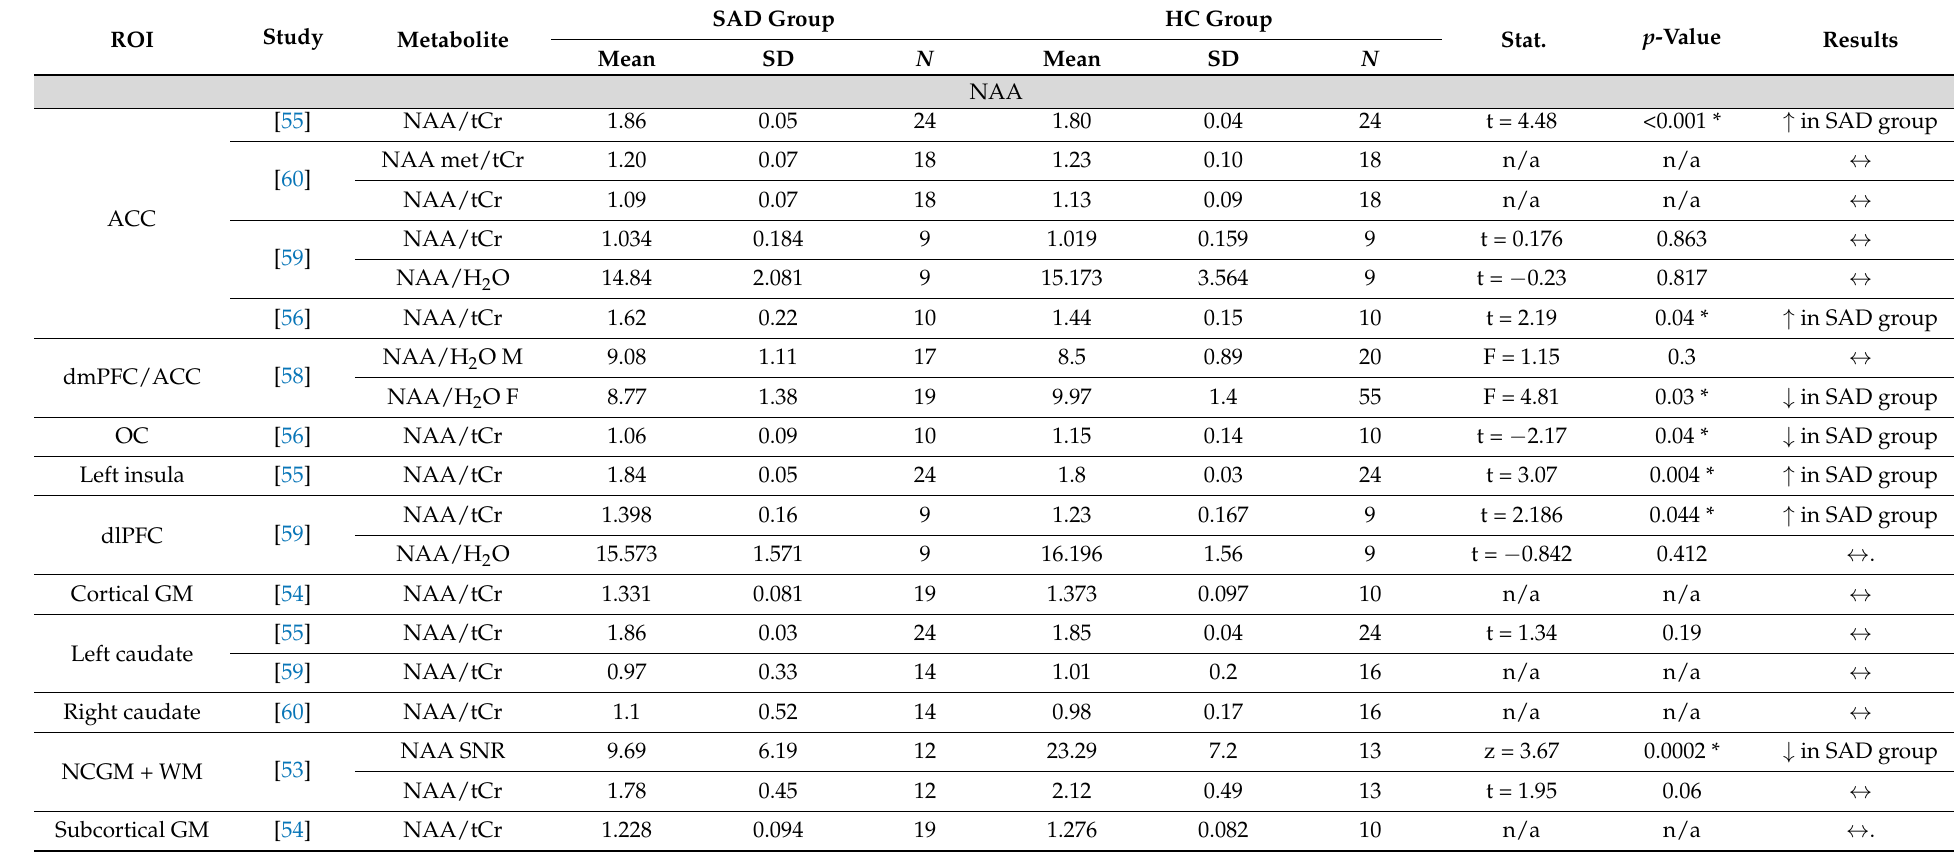
Table 2. Proton Magnetic Resonance Spectroscopy findings from cross-sectional studies . Abbreviations: ROI, region of interest; N , number of participants; SD, Standard Deviation; SAD, Social Anxiety Disorder; HC, Healthy Controls; M, male; F, female; Stat., statistics used; n/a, data not available; NAA, N-acetyl aspartate; tCr, total creatine metabolite; tCho, total choline; mI, myo-inositol; GABA, gamma-aminobutyric acid; Glu, glutamate; Gln, glutamine; Glx, glutamix; H 2 O, water; WM, white matter; GM, gray matter; NCGM, non-cortical gray matter; ACC, anterior cingulate cortex; dmPFC, dorsomedial pre-frontal cortex; dlPFC, dorsolateral prefrontal cortex; OC, occipital cortex; SNR, signal-to-noise ratio; ↑ , higher; ↓ , downregulated; ↔ , no differences between groups; asterisk indicates two-group comparison. NAA metabolite included NAA + NAAG (N-acetylaspartylglutamate) + NAA-N-acetyl-aspartate; Choline metabolites included Cho